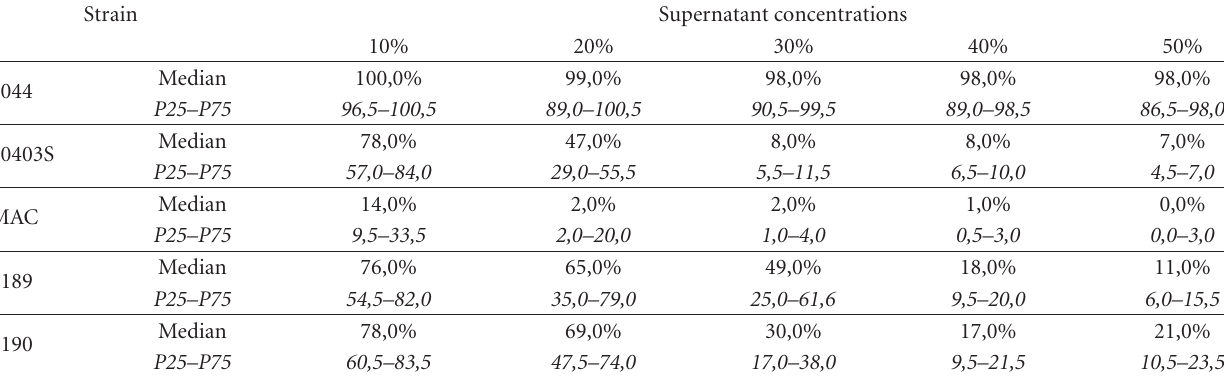
Table 3: Survival of PBMC cells of healthy person treated with di ff erent concentrations of L. monocytogenes strain supernatants.